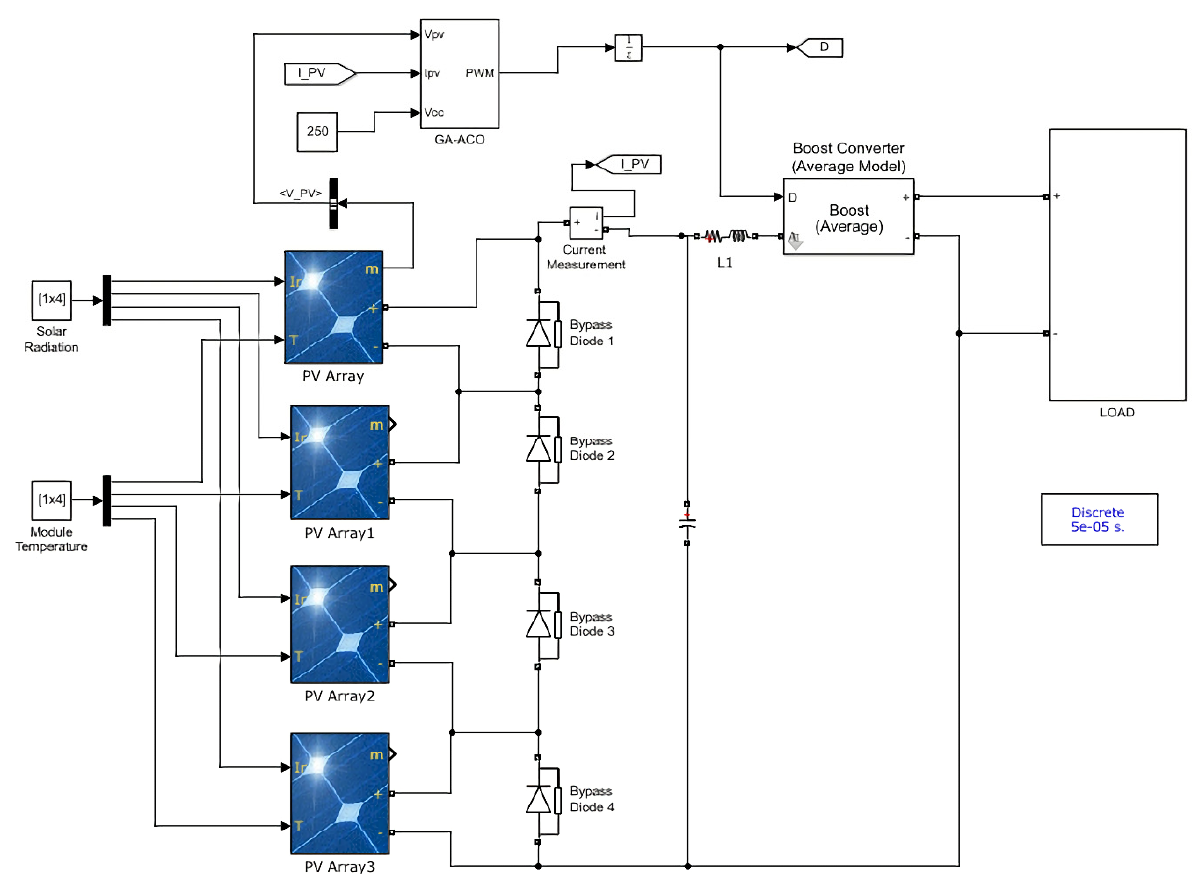
Figure 4. Circuit diagram of the proposed GA-ACO MPPT controller. Figure 4. C ircuit diagram of the proposed GA-ACO MPPT controller.